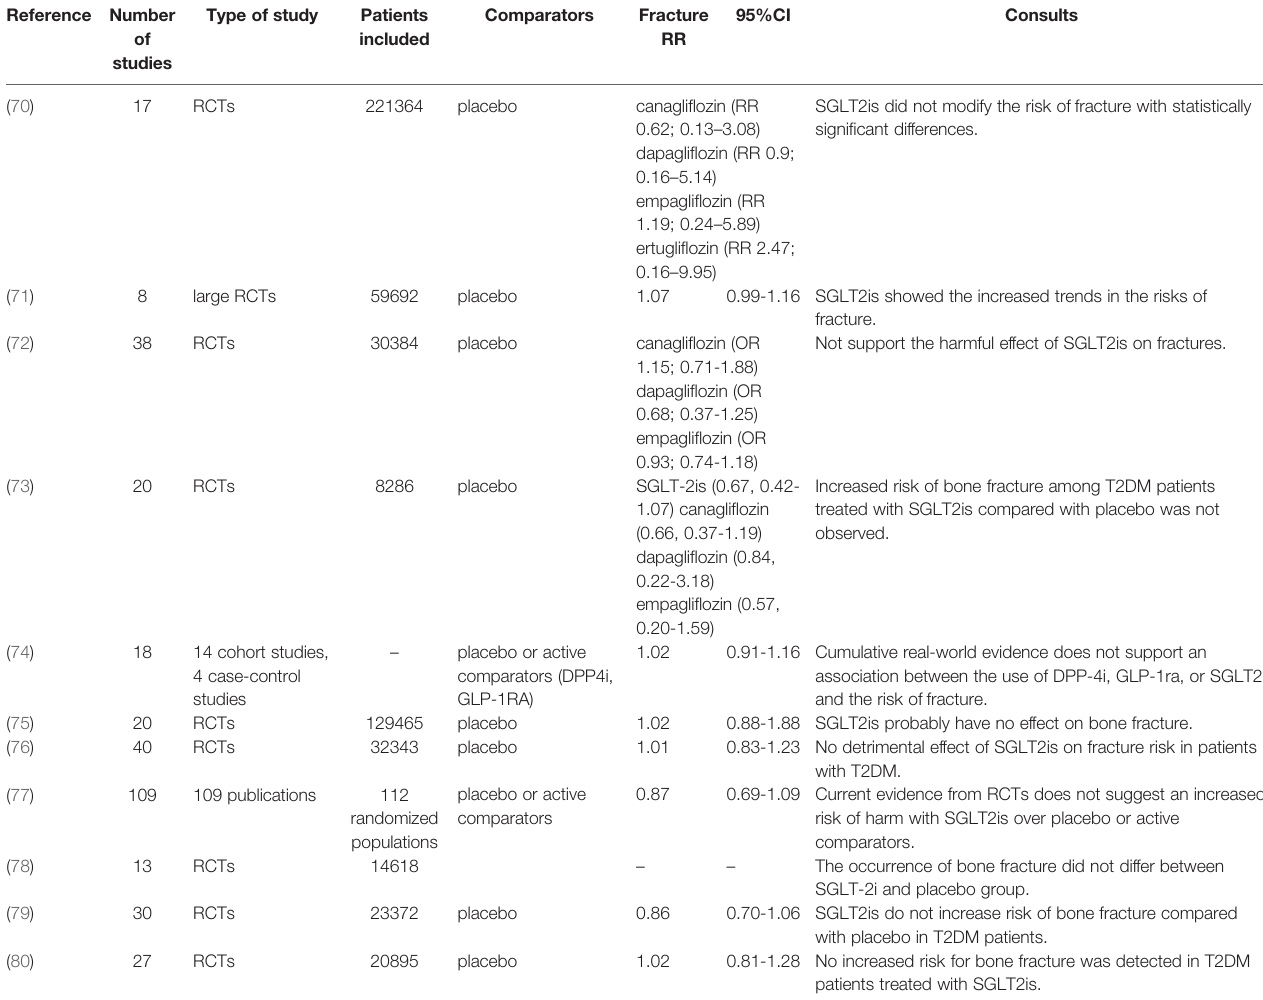
TABLE 4 | Meta-analysis of the effect of SGLT-2 inhibitors on bone